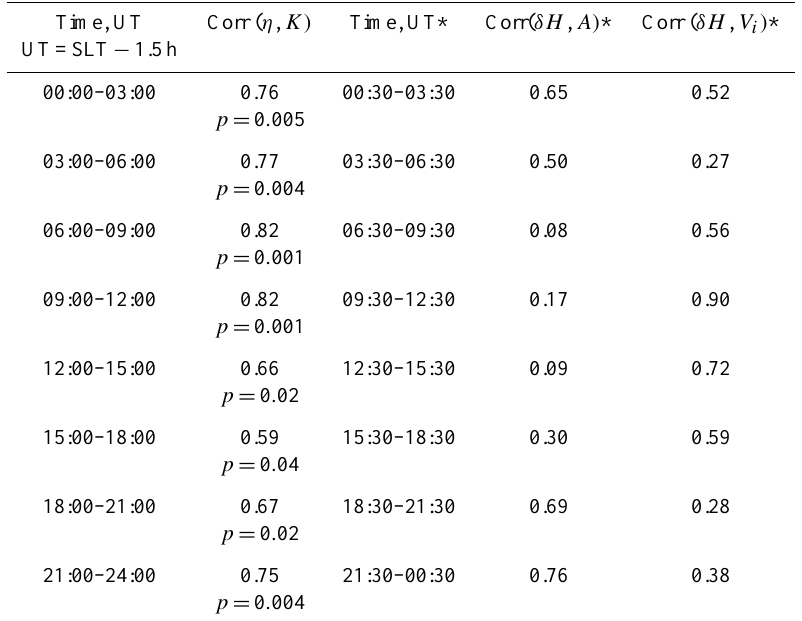
Table 3. Correlation